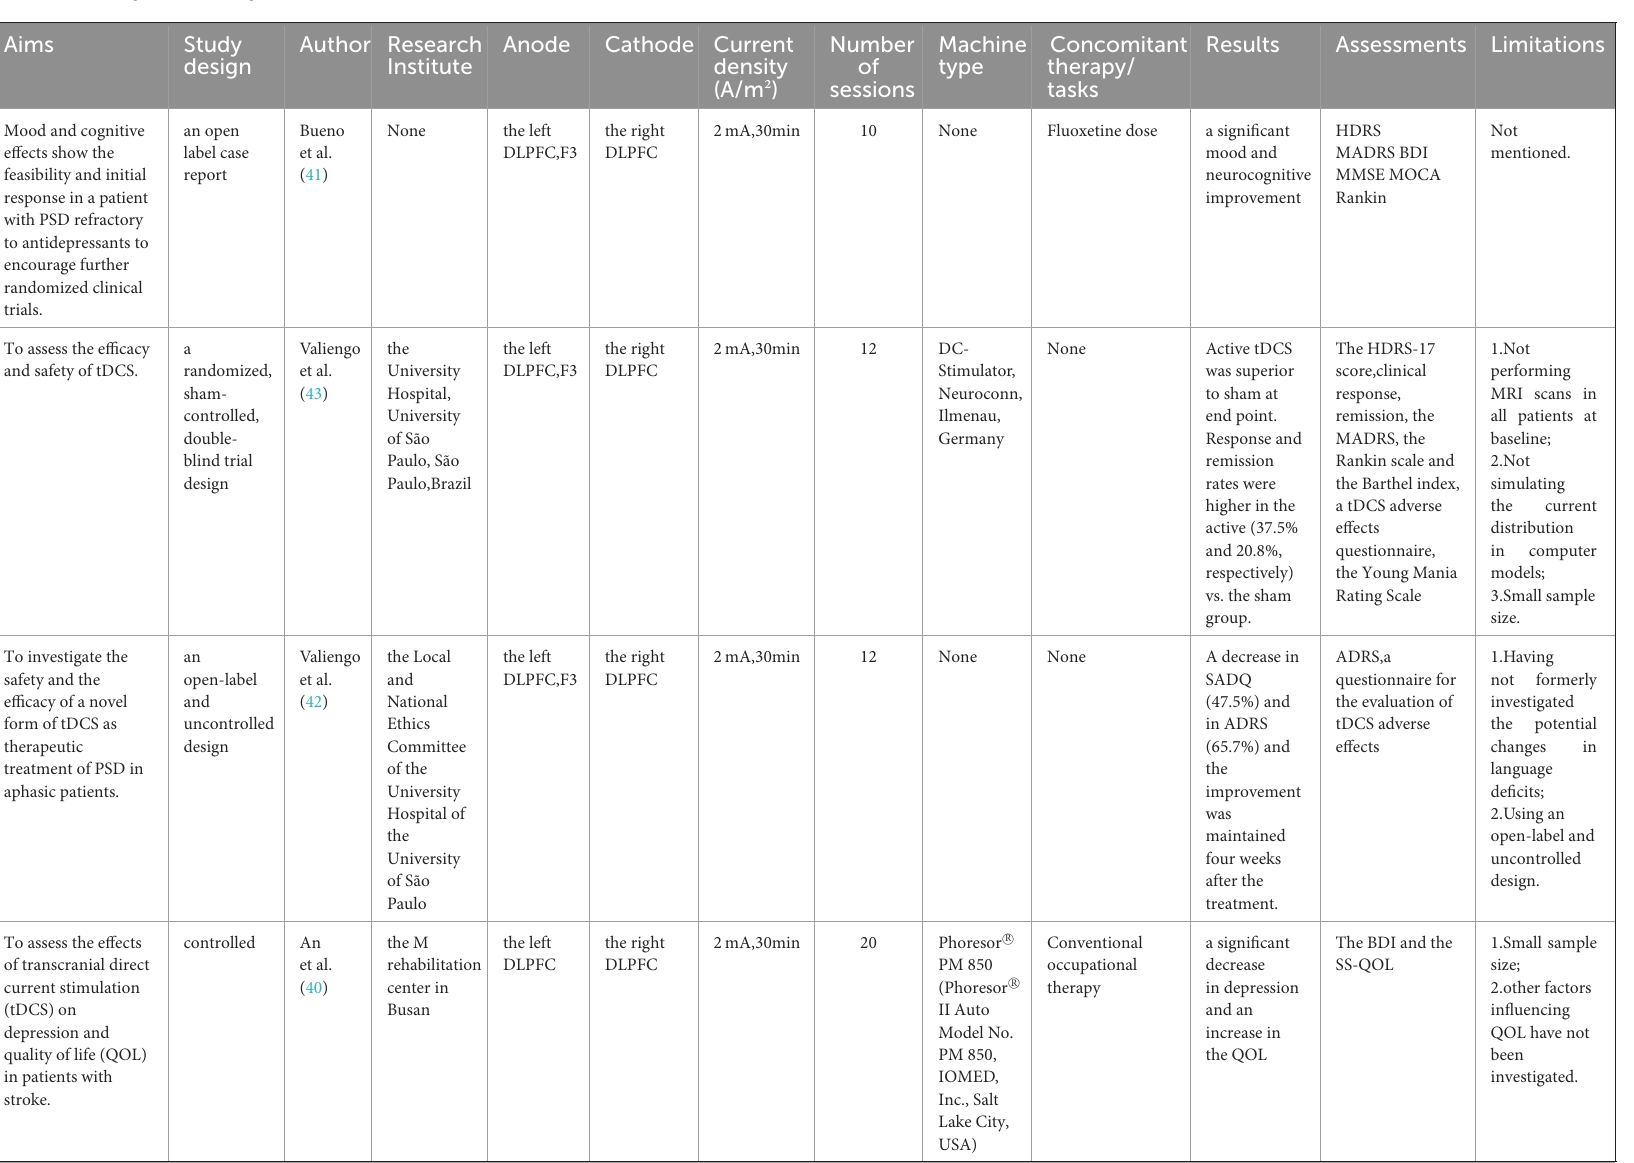
TABLE 3 Summary of tDCS study